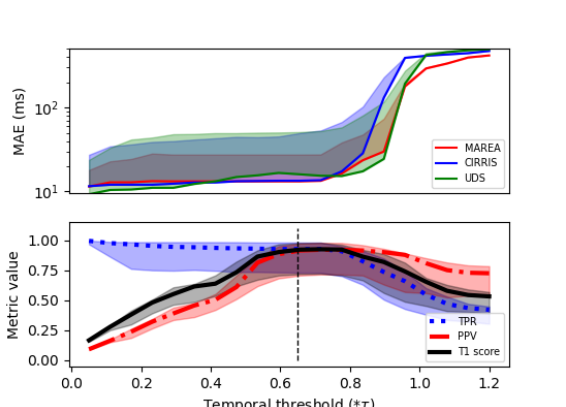
Figure A2. Performance according to the temporal threshold for peak detection (the shaded areas represent the variability over all the datasets and event classes). The lower, middle and upper line of the shaded areas correspond, respectively, to the 10th, 50th and 90th percentiles of the